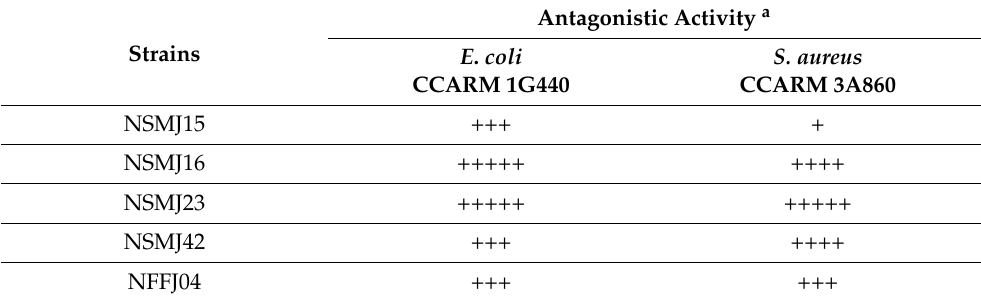
Table 2. Assays of antagonistic activities of five selected lactic acid bacteria (LAB) strains.